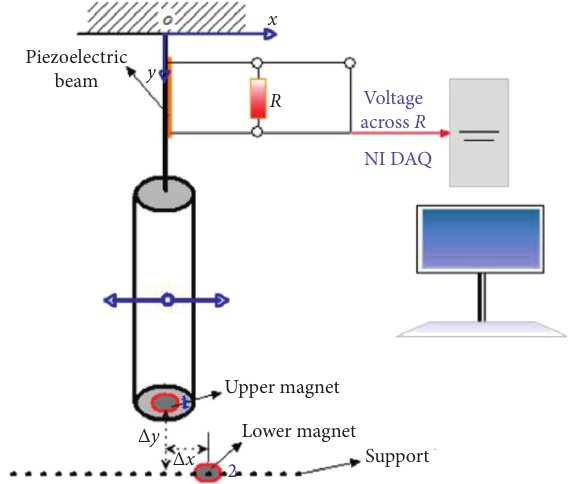
Figure 18: The VIV-based bistable energy harvesting system